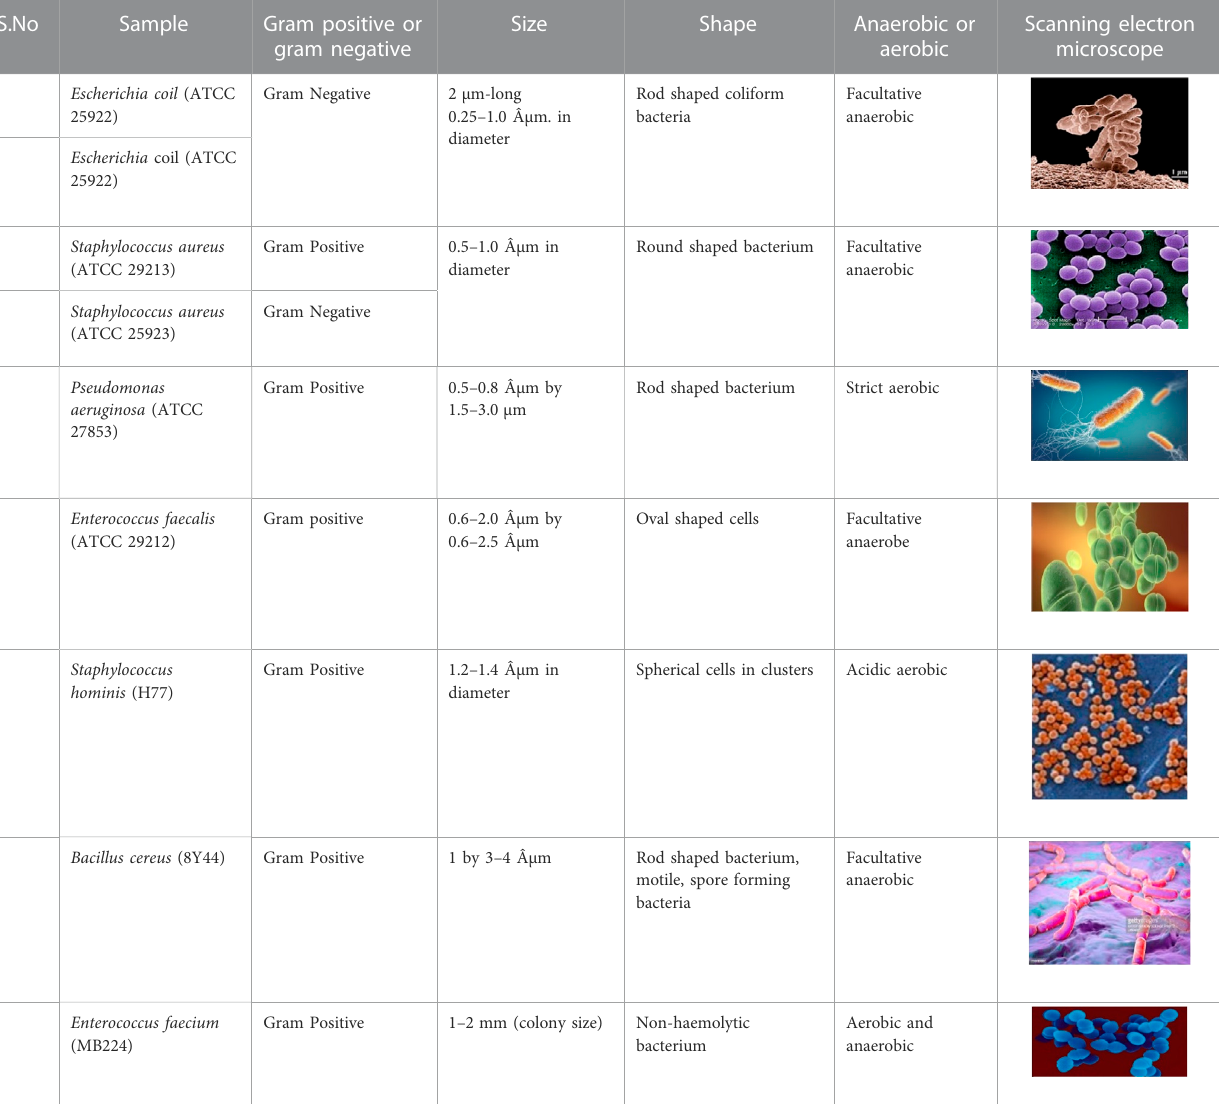
TABLE 2 The physical and biological characteristics of microbes studied along with their SEM